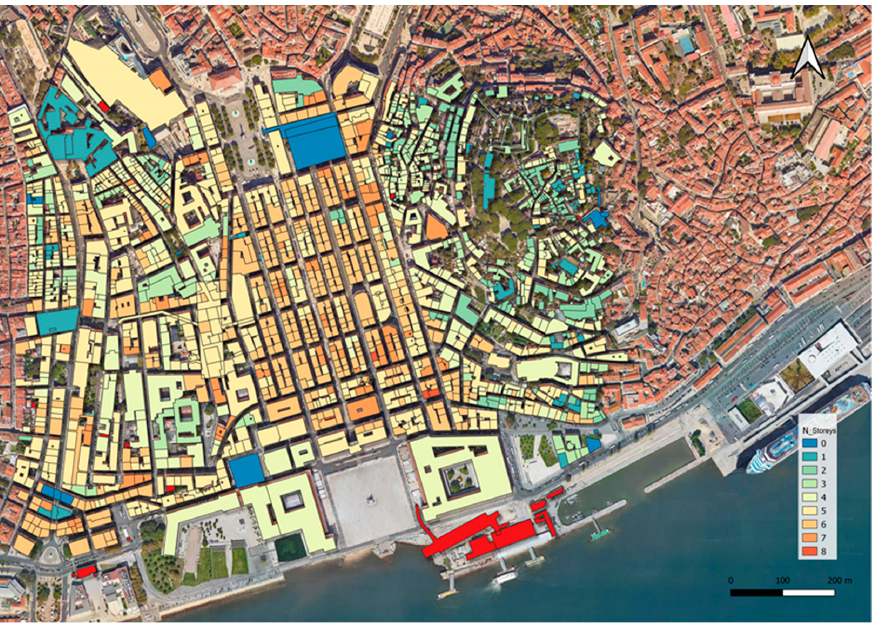
Figure 8. Number of floors for buildings in the historic center of Lisbon (adapted from Camara Municipal de Lisboa).